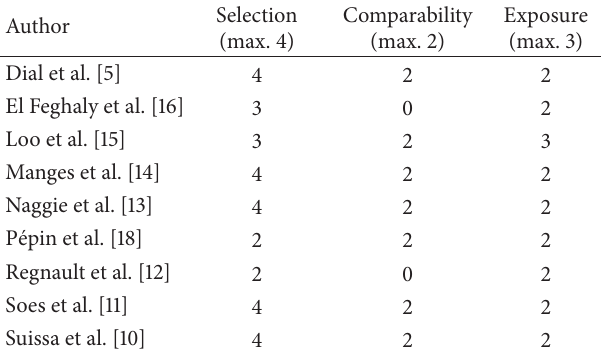
Table 2: Summary of quality